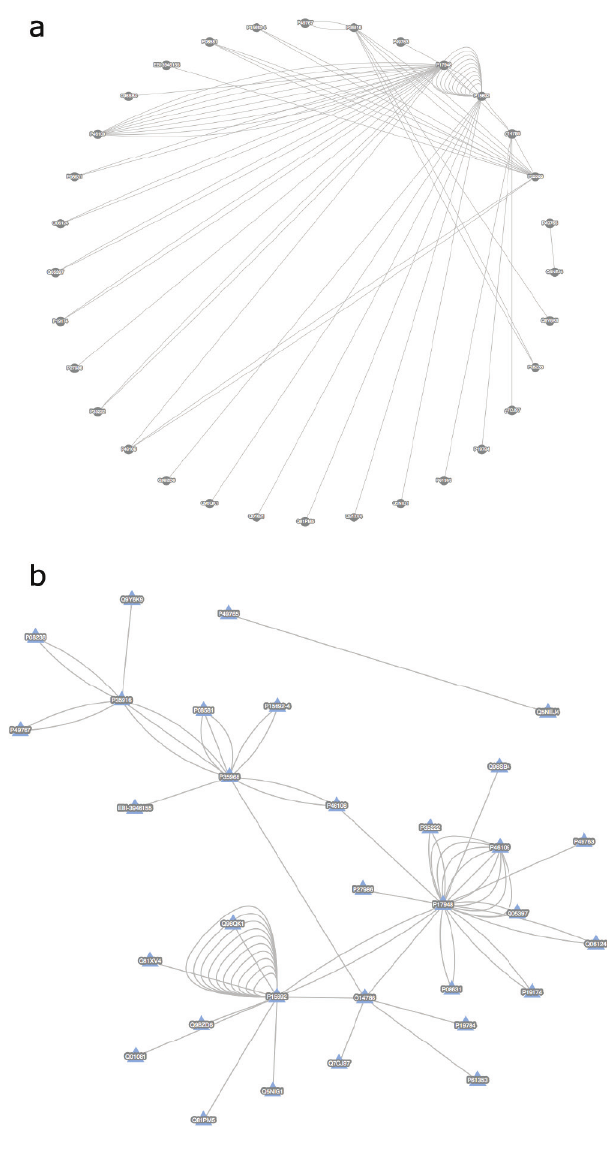
Figure 1. PsicquicGraph rendering of the proteins in the VEGF signaling pathway. The VEGF pathway is an essential regulator of vasculogenesis, as well as angiogenesis. In adults, it is up-regulated in a vast number of tumors. Solid tumors often build novel blood vessels and VEGF is one important regulator in that development. It is also a drug target in tumor medicine and several drugs directly target the VEGF receptor to block blood vessel formation in tumors. ( a ) Default values were